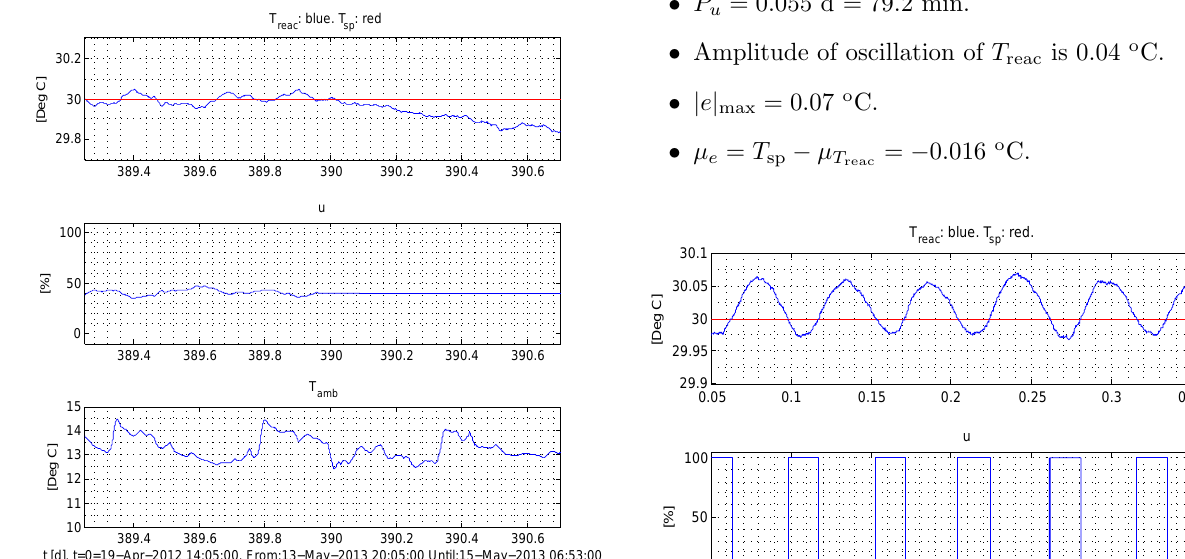
Figure 3: Responses on the real reactor (ADR2): t = 389 . 25 - 389 . 80 d: Automatic closed loop (feed- back) temperature control. t = 389 . 80 - 390 . 75